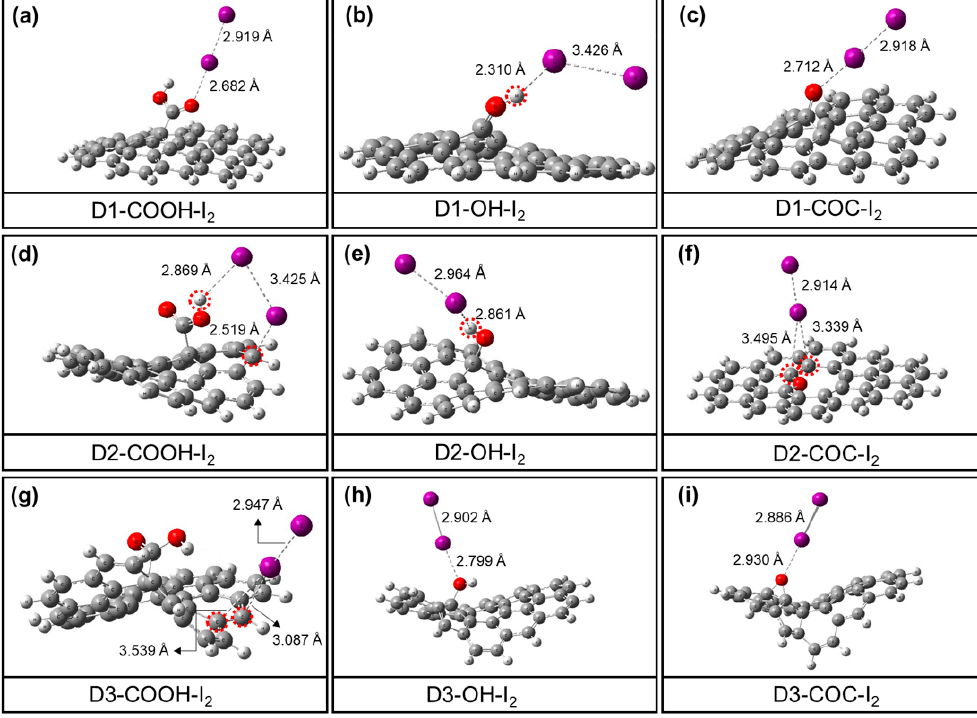
Figure 10. Adsorption energy of the iodine molecules and the oxygen functional groups in single-defect structure (D1), double-defects structure (D2) and triple-defects structure (D3).